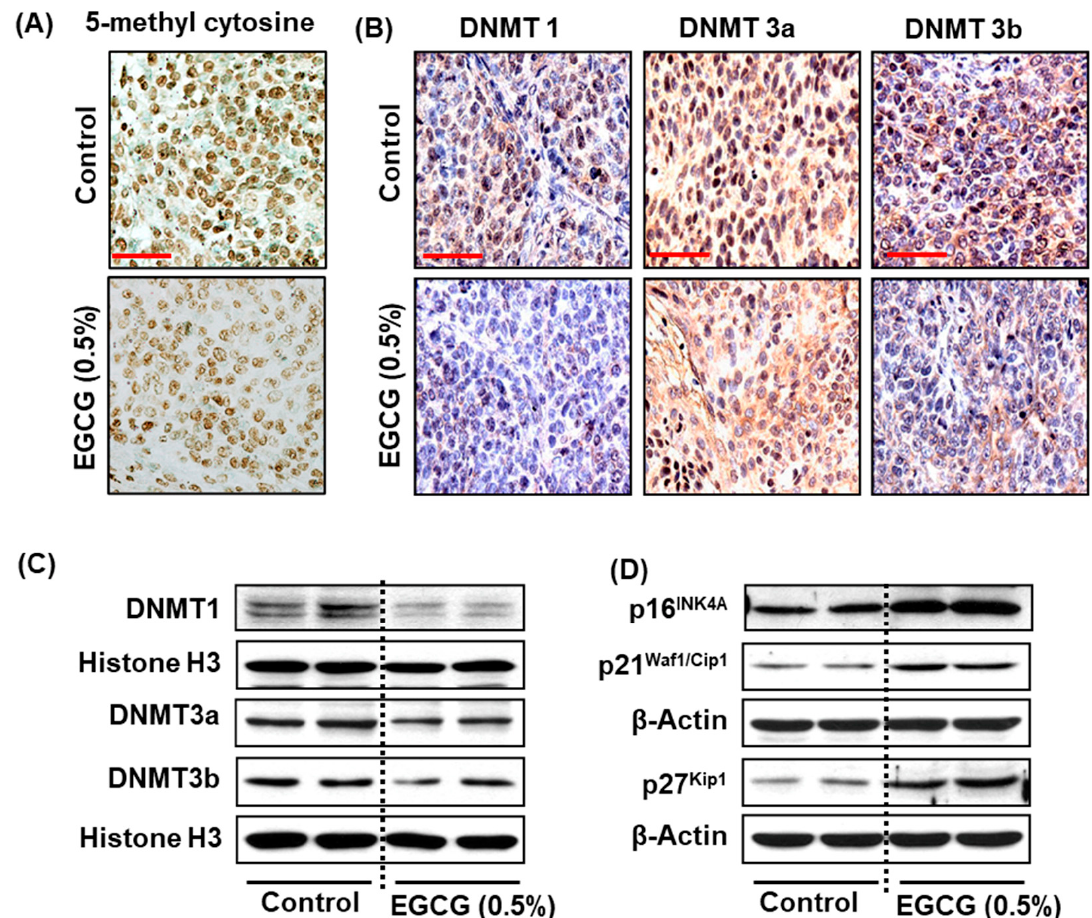
Figure 7. Effect of dietary administration of EGCG on epigenetic changes and tumor suppressor proteins in FaDu tumor xenografts in BALB/c nude mice. At the termination of the experiment, tumors from all groups were harvested and subjected to epigenetic changes. The effect of EGCG on global DNE methylation was assessed by immunostaining of 5-mc ( A ). The changes in DNMT1, DNMT3a, and DNMT3b protein expression were observed by immunostaining ( B ) and Western blot ( C ). EGCG administration increased the expression of p16 INK4a , p21 Waf1/Cip1 , and p27 Kip1 ( D ). Each column of the Western blot represents a pool of two tumor samples, obtained from two different mice. n = 4.